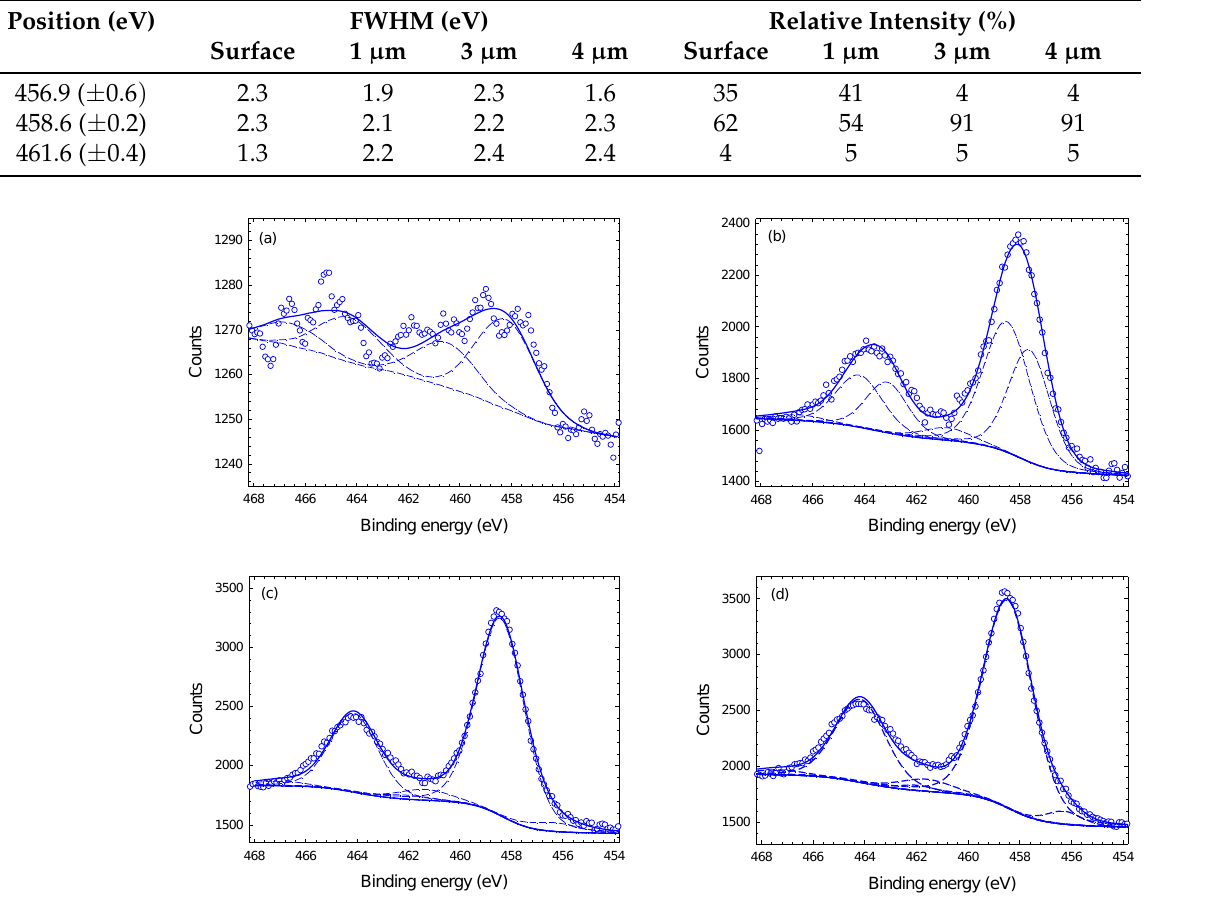
Figure 6. Typical Ti-2p XPS spectra of Ti x -Cu y N z film at different depths: ( a ) at the surface (smoothed), ( b ) 1 µ m, ( c ) 3 µ m, and ( d ) 4 µ m. The data are fitted with Lorentzian–Gaussian peaks after subtraction of a Shirley